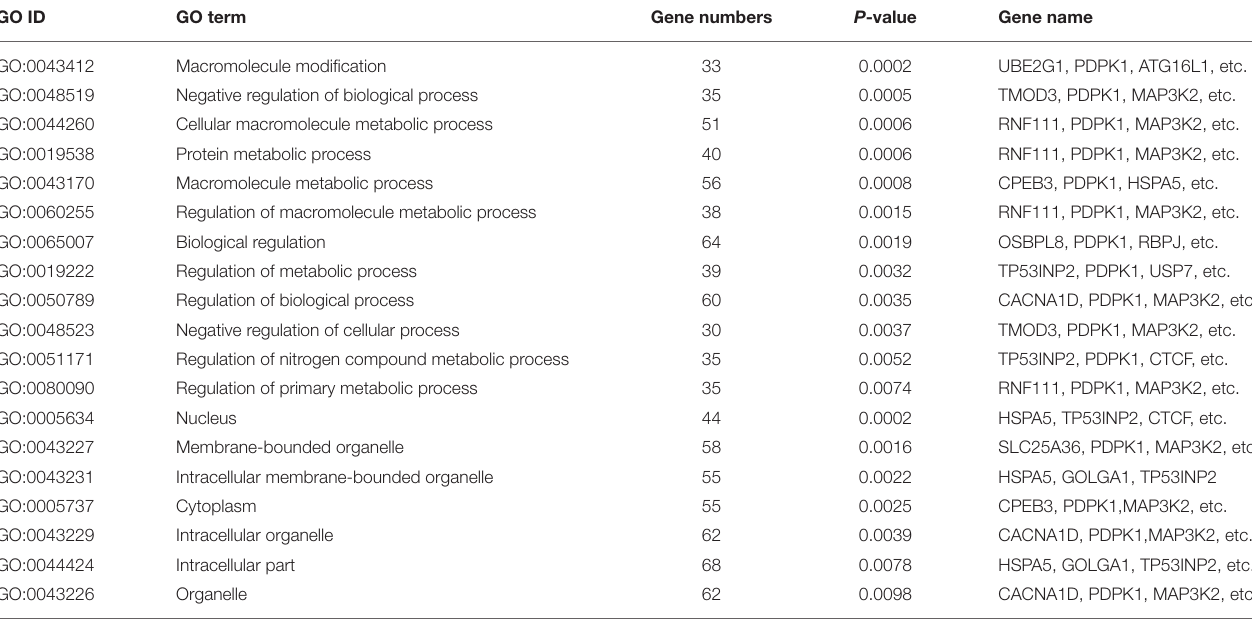
TABLE 4 | GO enrichment analysis of gga-miR-148a-5p target genes. GO ID